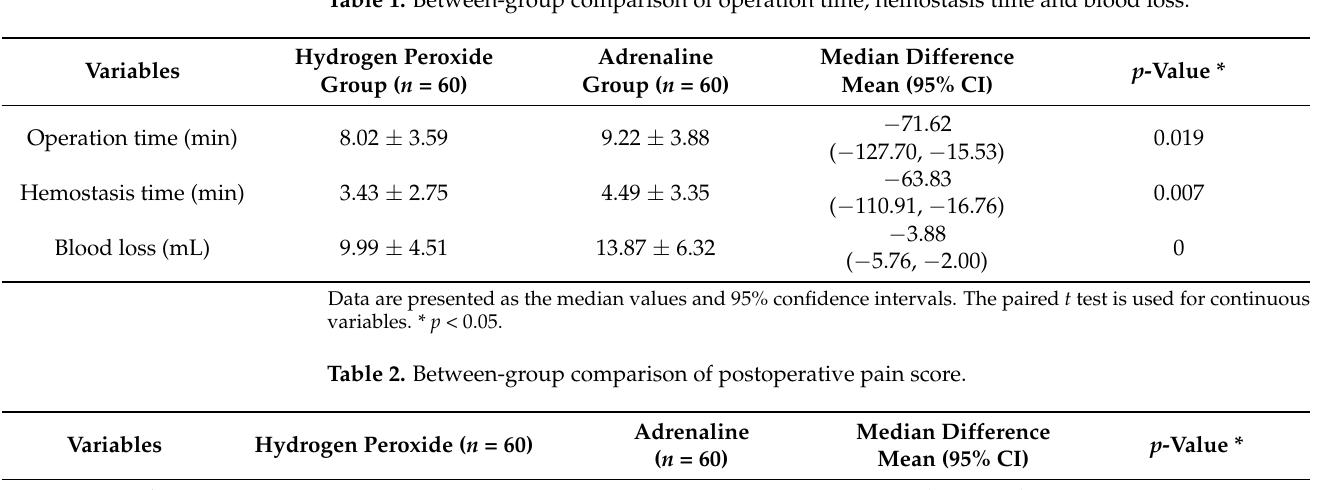
Table 1. Between-group comparison of operation time, hemostasis time and blood loss.